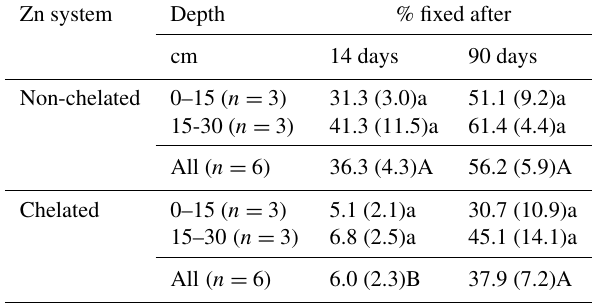
Table 2. Average % (with standard deviation) plant-available Zn fixed after 14 and 90 days in the non-chelated and chelated systems of the semi-arid alkaline soils of the Southern High Plains,